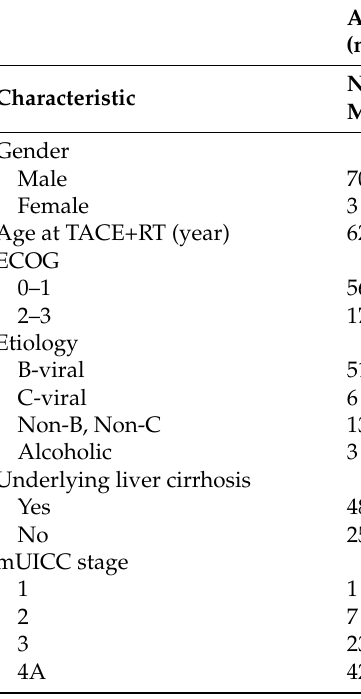
Table 1. Patient and tumor